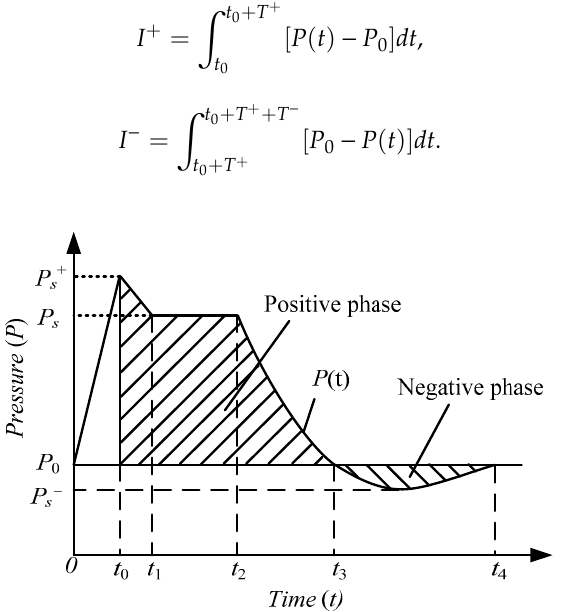
Figure 7. Impact pressure–time history curve of the liquid carbon dioxide blasting system.